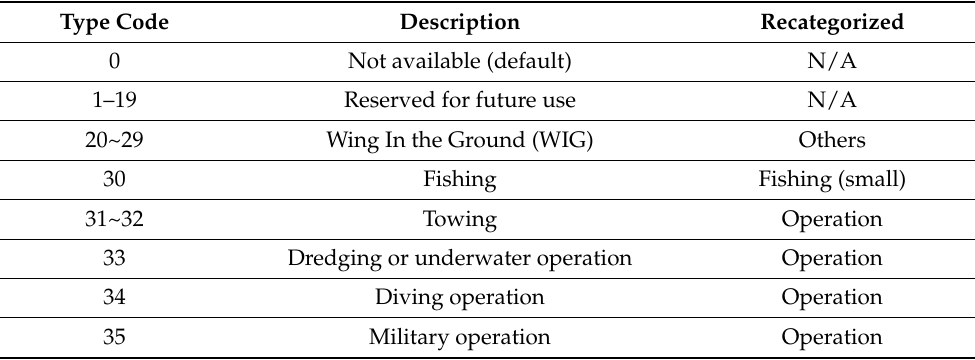
Table 5. Recategorization of ship